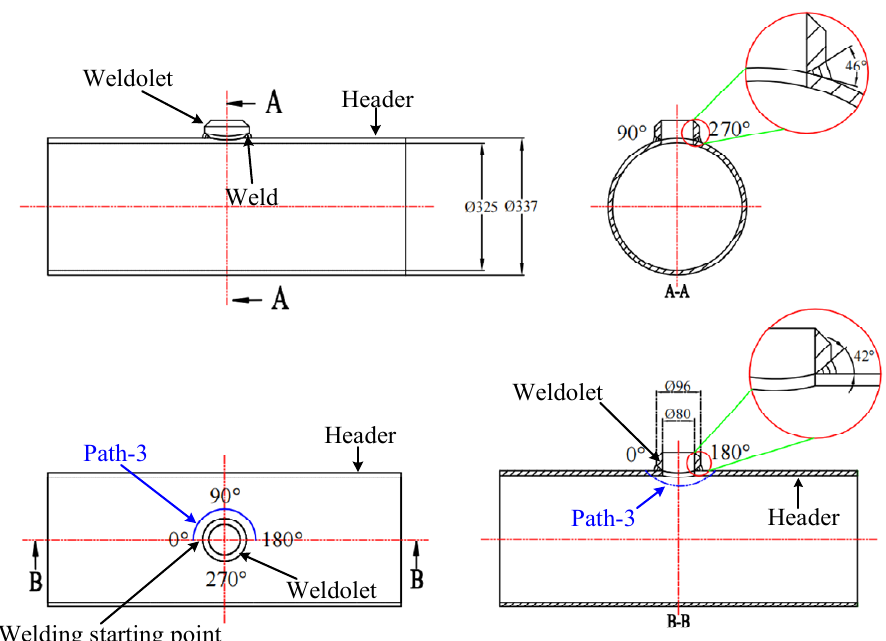
Figure 1. Two-dimensional (2D) schematic diagram of the weldolet-header structure.